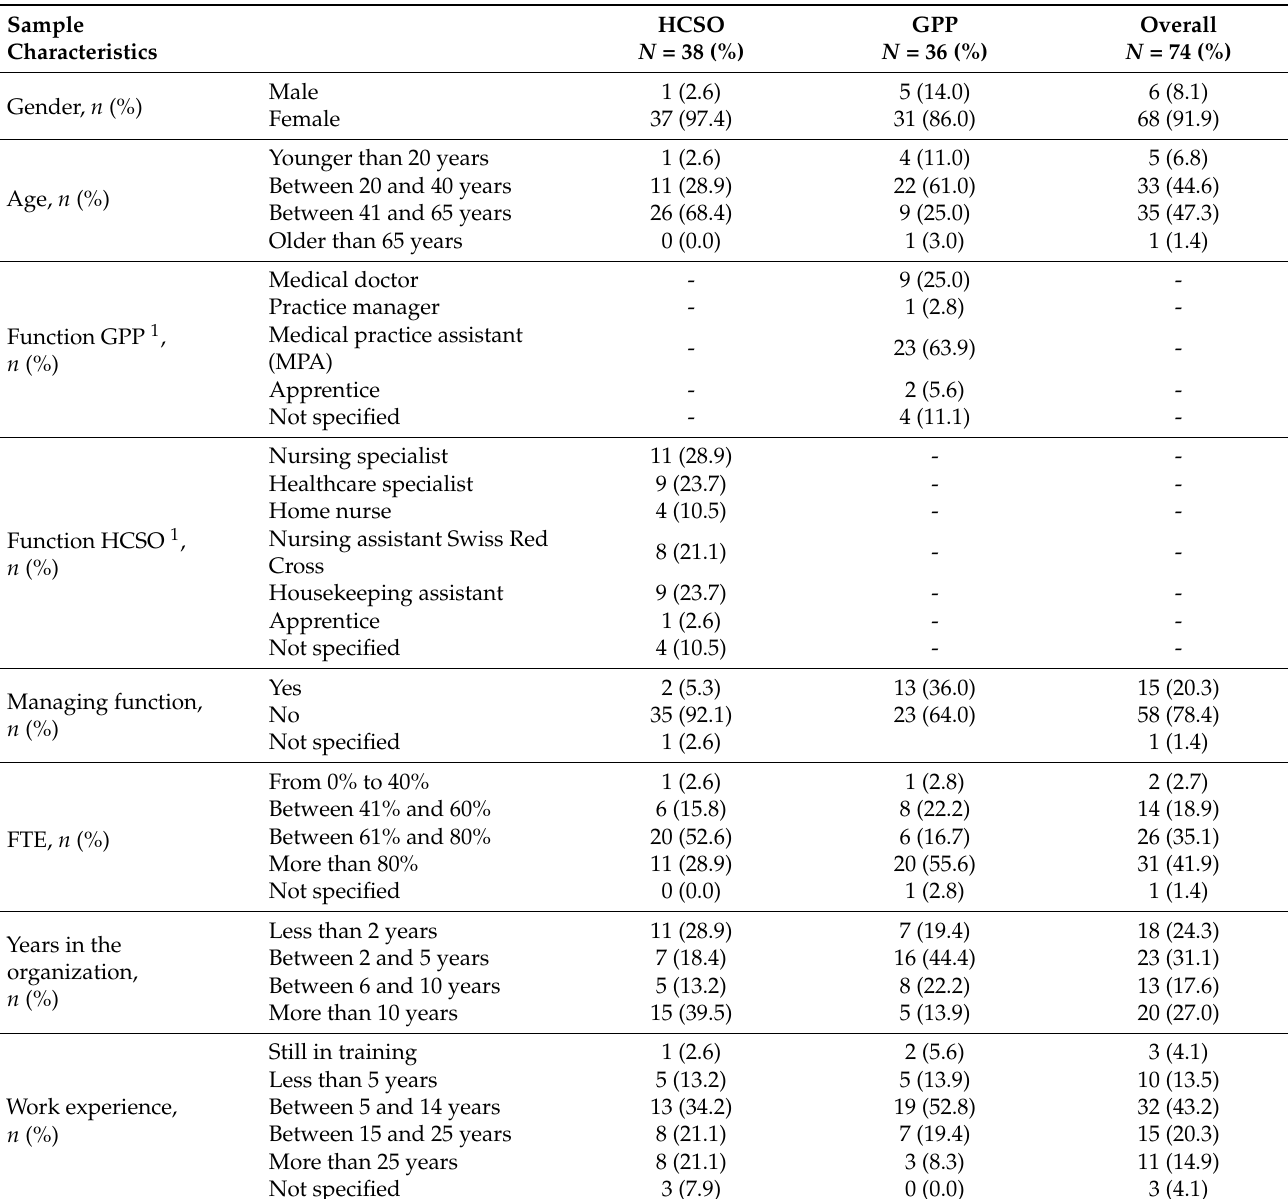
Table 2. Socio-demographic characteristics of the sample of the online survey ( N =